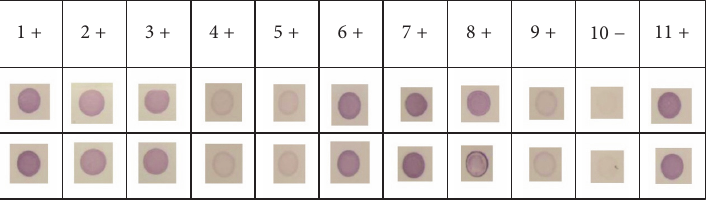
Figure 2: It is observed that in 7 patients there is a strong ligation between the designed bacterial epitope and obtained antibodies of blood